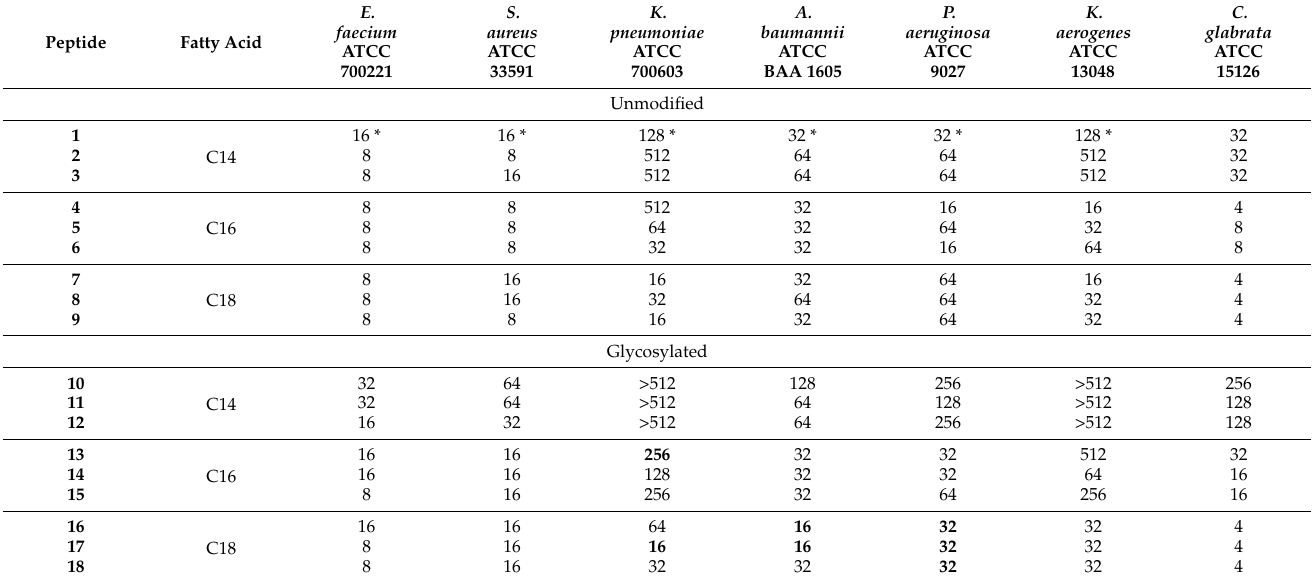
Bolded values indicate enhanced activity for gUSCLs in comparison to USCLs. * The analyses performed by our group in the previous study